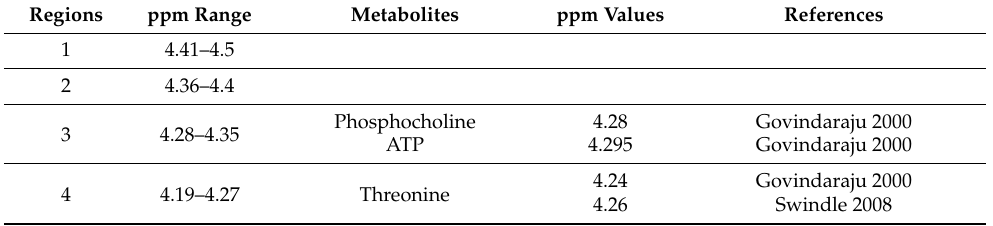
Table A2. Assignment of metabolites to ppm values of chemical shift according to the